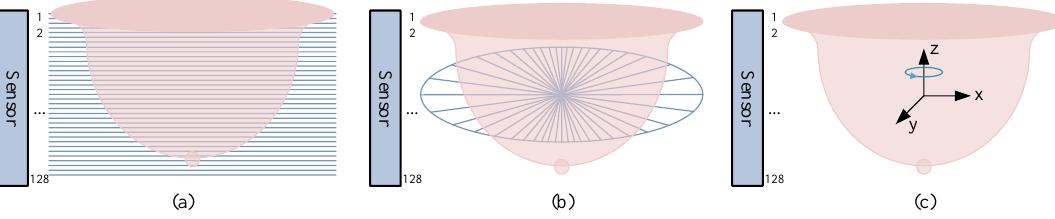
Figure 4. Multi-perspective breast ultrasound imaging. ( a ) Vertical slice ( b ) Horizontal slice. ( c ) 3D